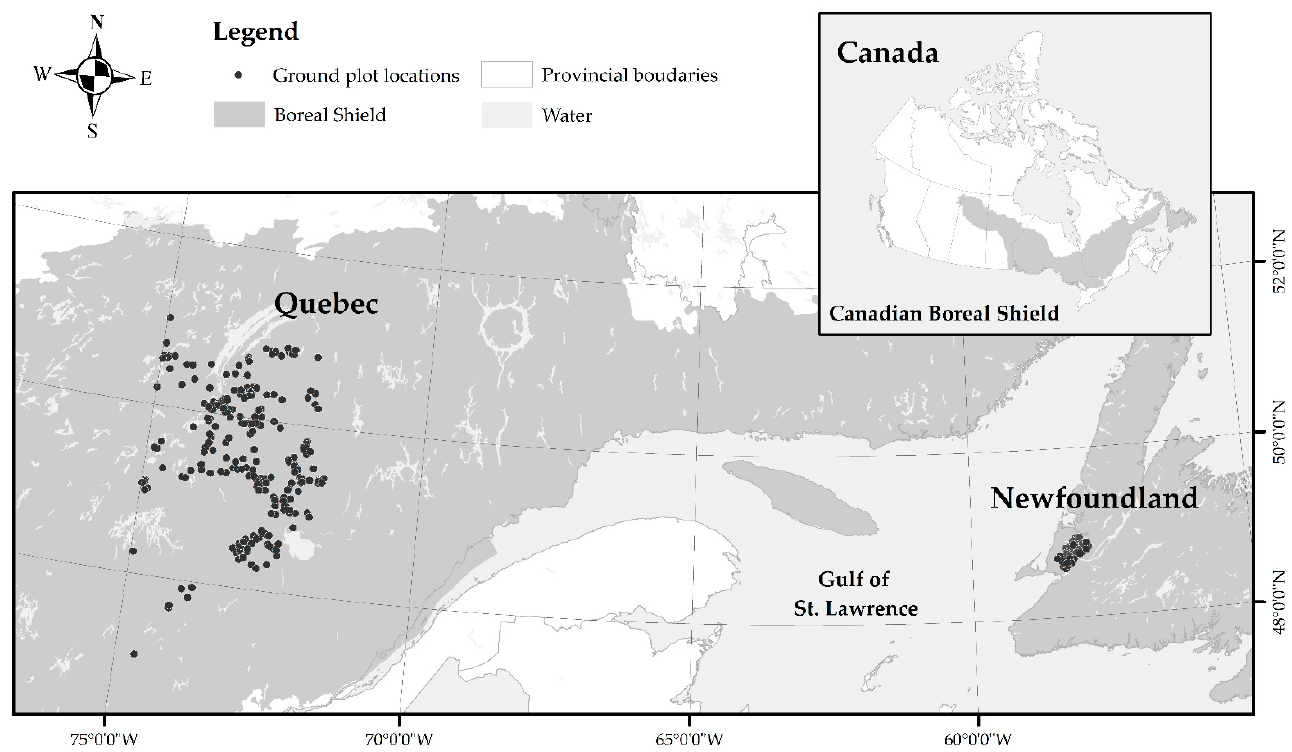
Figure 1. Plot distribution across two sites within the eastern Boreal Shield, Canada.